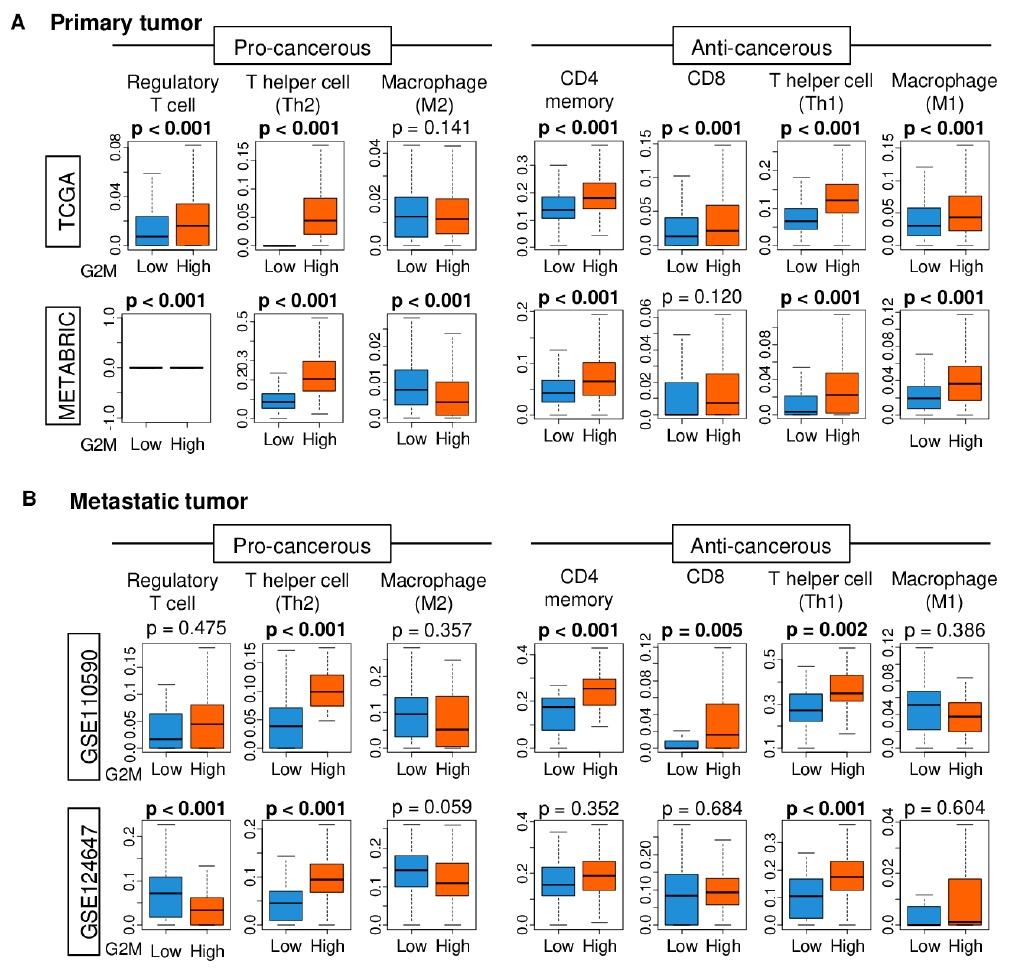
Figure 5. Boxplots of immune cells, CD8 T cell, CD4 memory T cell, T helper cell type 1 and 2, M1 and M2 macrophage, and regulatory T cells depicting the high and low G2M scores ( A ) in primary tumors and ( B ) in metastatic tumors.